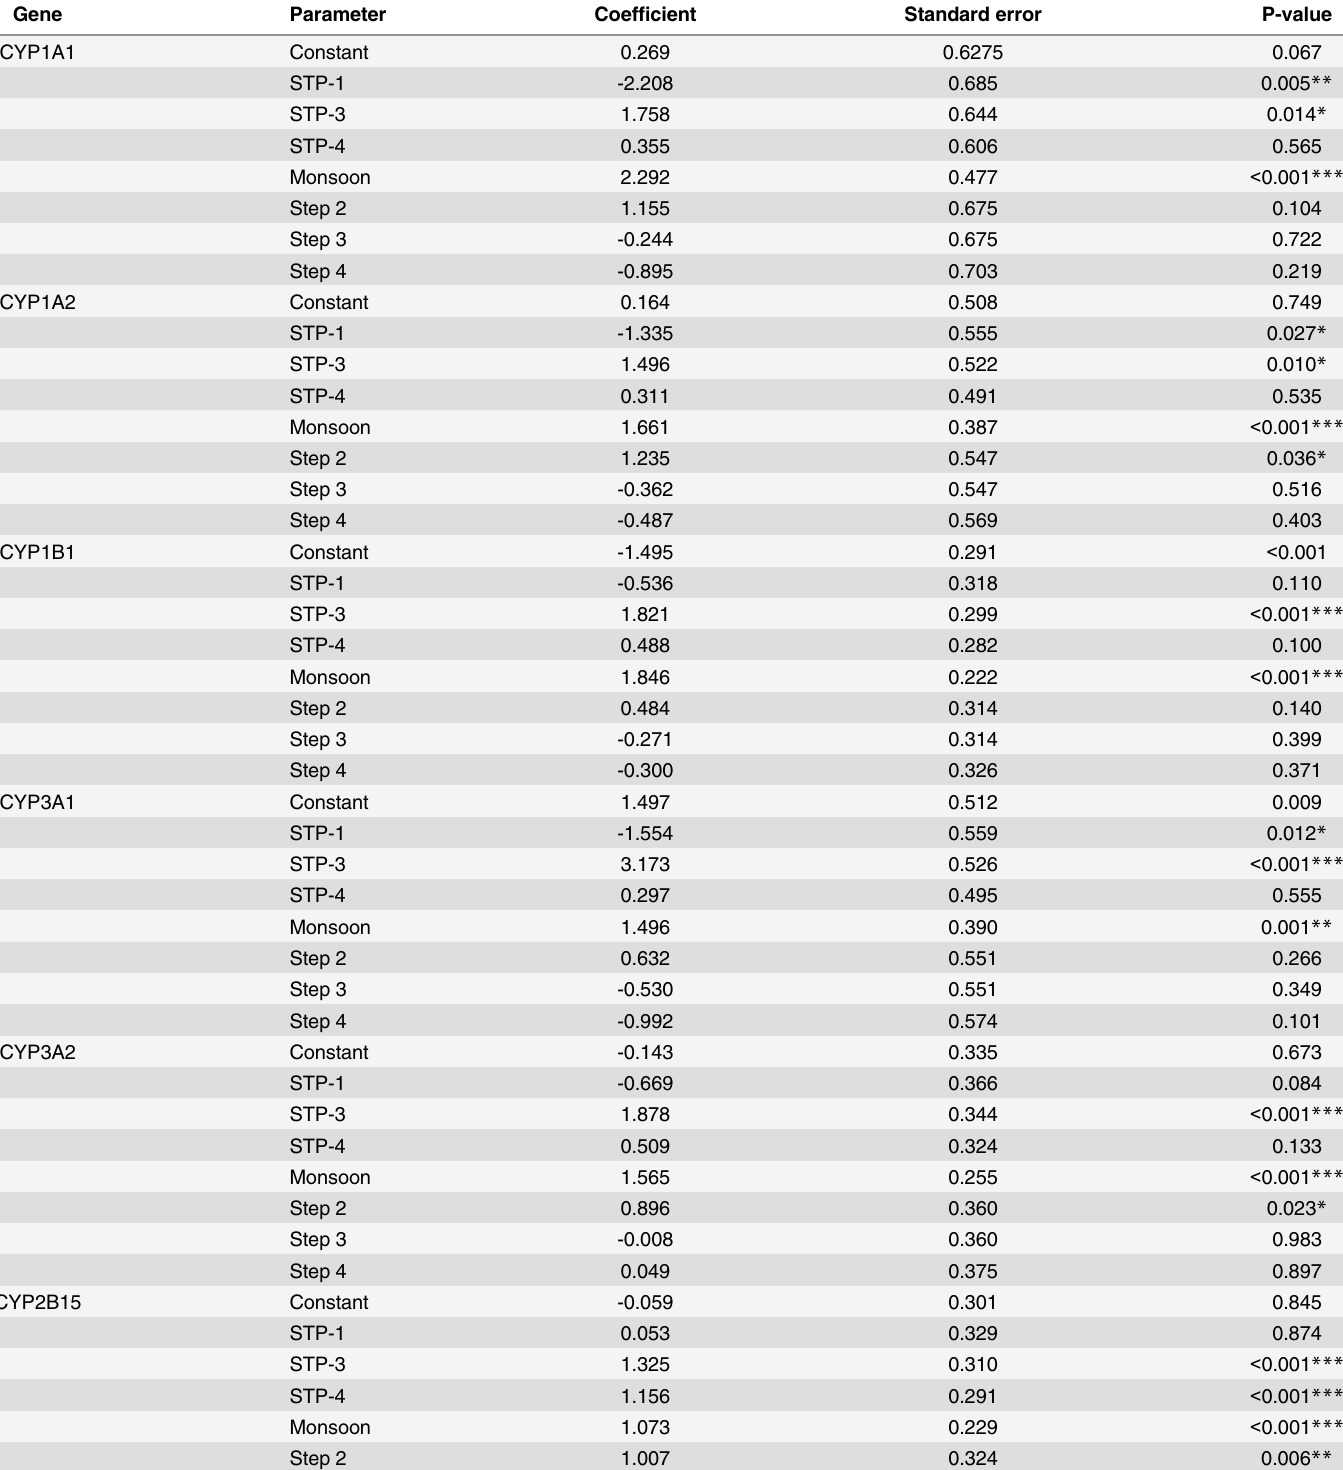
Table 2. The estimated associations between gene expression potential and sewage treatment facility, season and treatment process in STP wastewater.